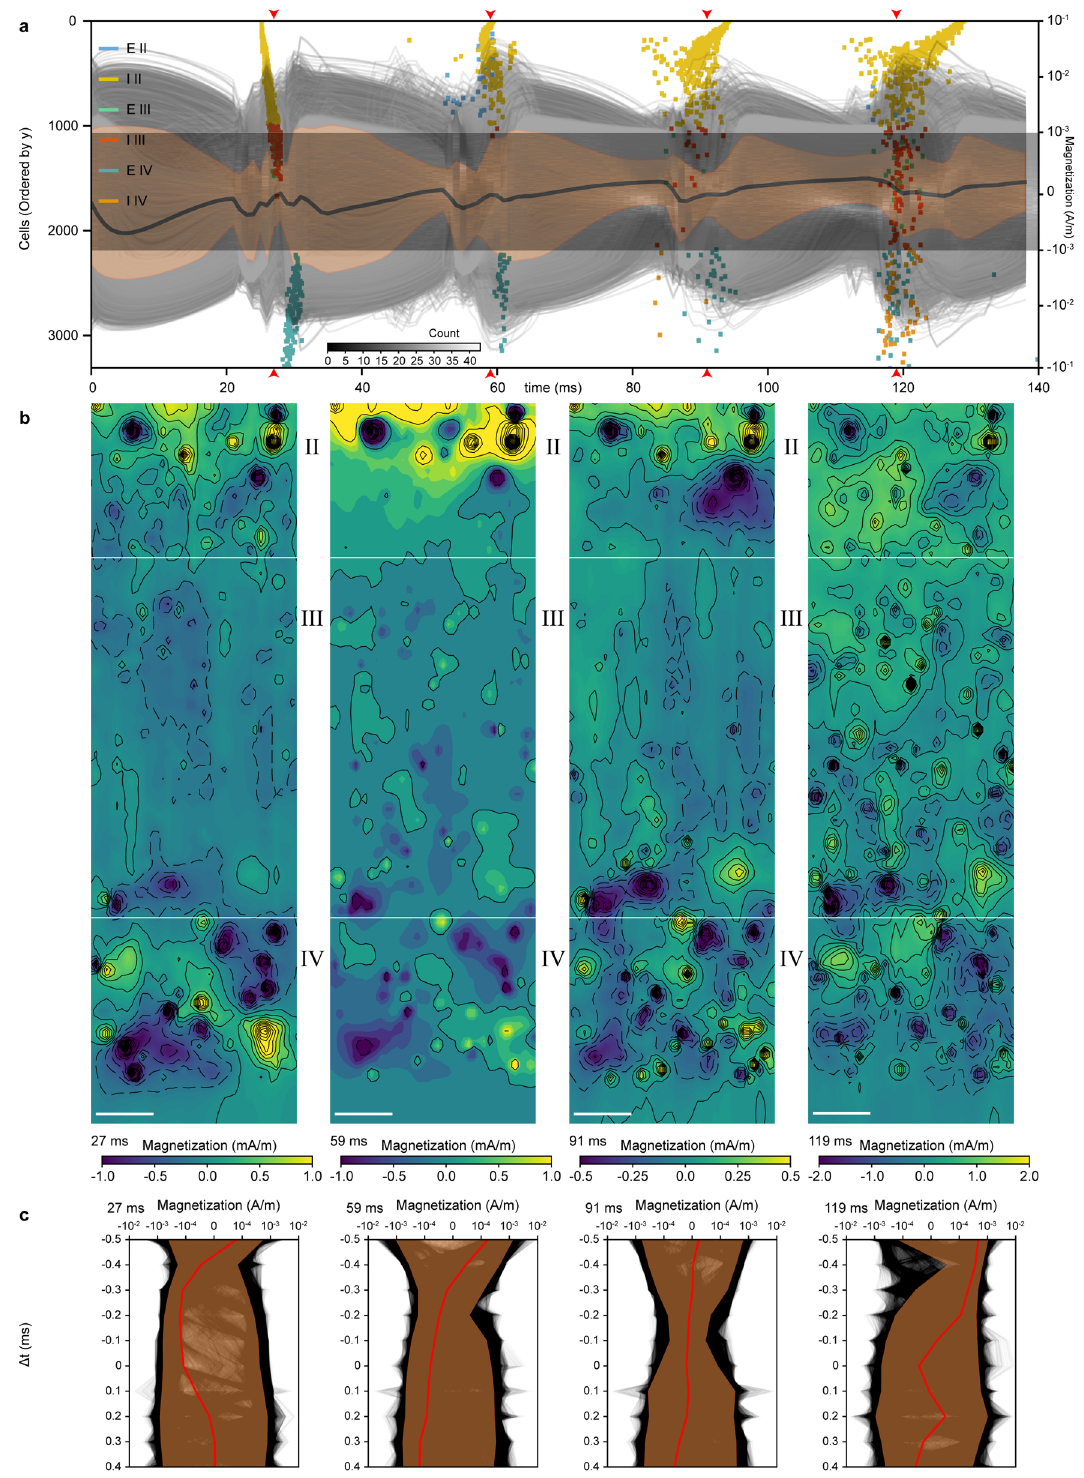
Figure 5. Magnetization of MENPs within a simulated cortical voxel. ( a ) Firing activity of neurons within the simulated neocortical slice (E = excitatory, I = inhibitory cells) over a 140 ms period. Layers II, III, and IV of the neocortex were simulated, each 150 µm, 350 µm, and 200 µm thick, respectively, (total thickness = 700 µm). Mean firing rates were 6.20 Hz and reached 19.13 Hz during network bursts. Composite magnetization traces (grayscale) overlaid on a time-dependent histogram (grayscale). Grayscale traces are the magnetization at recording sites color-coded by distance from the slice center (lighter = further from center). The thick black line is the mean magnetization in the slice, while the orange swath is the standard deviation. The time-dependent histogram covers the linear regime of the symmetric log plot (from −1 to 1 mA/m), with bin dimensions of 1 ms by 5 μA/m. ( b ) Static yz magnetization colormaps through x = 100 µm for each of four timepoints marked by red arrows in panel a). Scale bar = 50 µm. ( c ) Monte Carlo magnetization simulations for perfused MENPs. Single particles were centered at each of the four times (i.e. 27 ms, 59 ms, 91 ms, 119 ms) and traversed through the neural network vertically from the top (y = 0 µm) to bottom (y = 700 µm) edge. The thick red line is the mean magnetization, and the orange swath is the standard